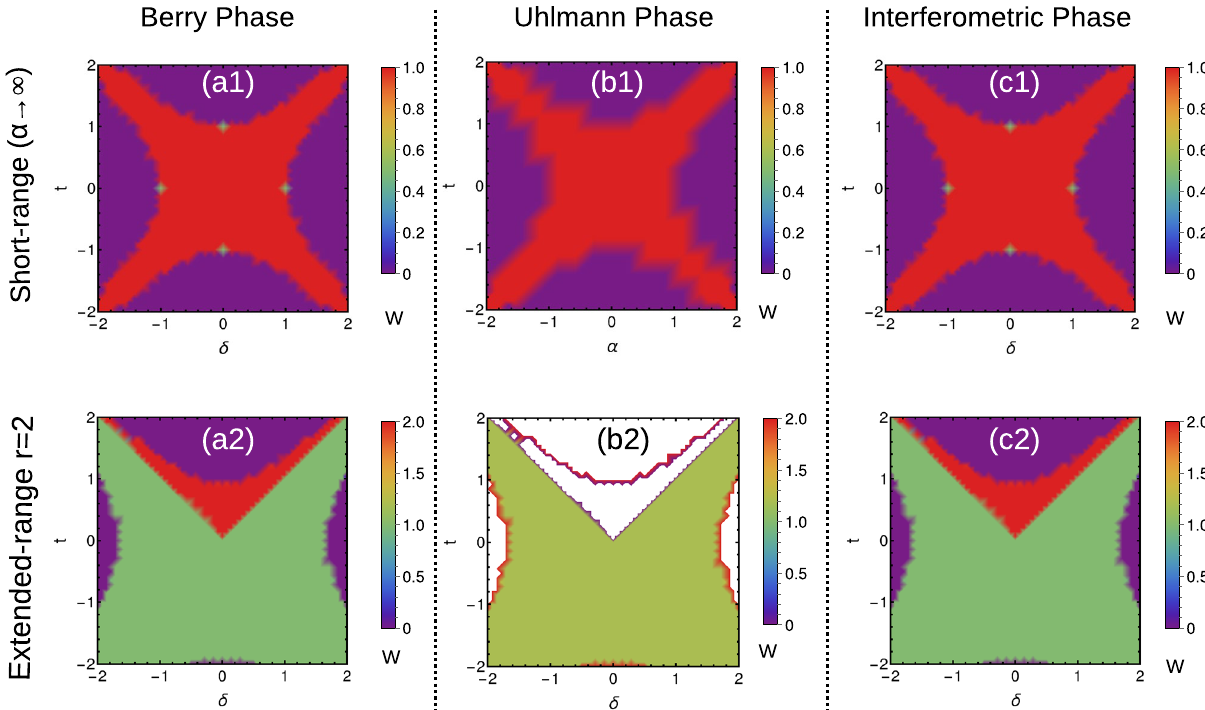
Figure 12. (Color online) Phase diagrams of non-Hermitian SSH chain in generalized Brillouin zone with t 1 and α 0.1 (the construction of generalized Brillouin zone is given in “Method” section). The geometric ′ = = 2 ) models are represented in pure and mixed state phases of short-range ( α ) and extended-range ( r → ∞ = forms. The Uhlmann phase shows some limitation in defining the geometric phases at finite